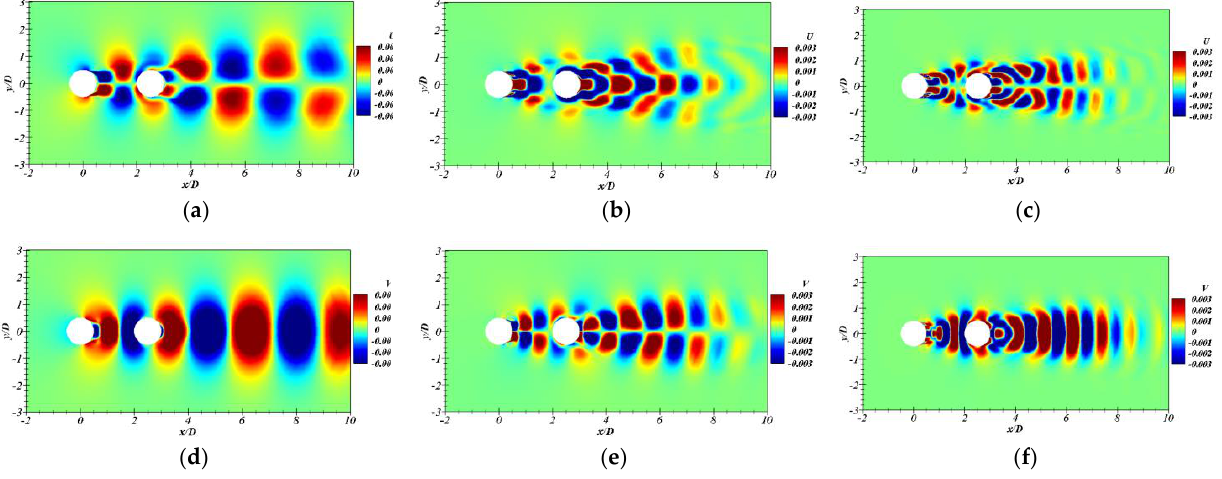
Figure 17. Spatial structures of velocities for 𝐿/𝐷 = 2.5 : the streamwise velocity for ( a ) Mode 1; ( b ) Mode 2; ( c ) Mode 3 and the cross-flow velocity for ( d ) Mode 1; ( e ) Mode 2; ( f ) Mode 3.